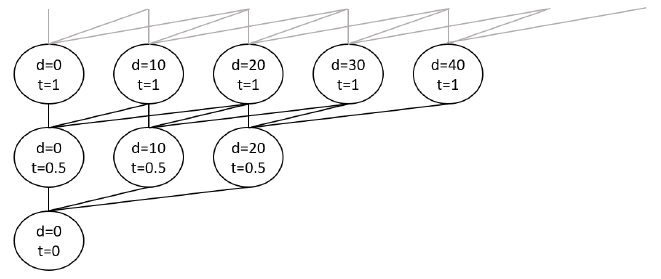
Figure 1. Fragment of speed selection graph near source